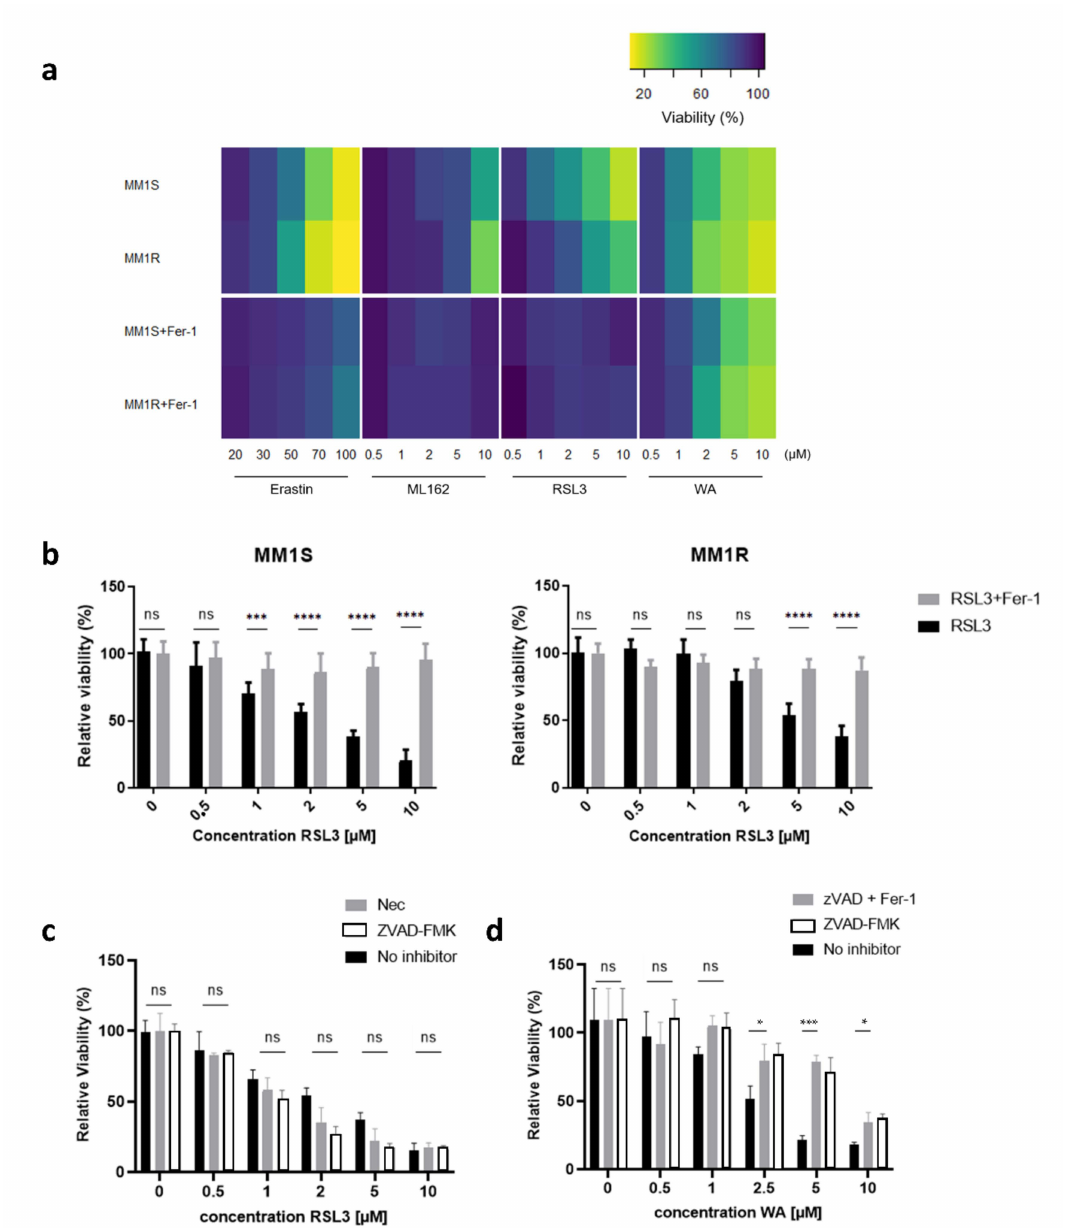
Figure 1. MM1 multiple myeloma cell lines are susceptible to ferroptosis induction. ( a ) Heatmap representing relative cell viability of MM1 cells upon 24 h exposure to increasing concentrations of erastin, ML162, RSL3, and withaferin A (WA) with or without pre-treatment with ferroptosis inhibitor ferrostatin-1 (Fer-1). ( b ) Relative cell viability of MM1S (left) and MM1R (right) cells upon 24 h exposure to increasing concentrations of RSL3 with or without pre-treatment with 2 µ M ferrostatin-1 (Fer-1). Data are plotted as the mean ± s.d., n = 3 biologically independent replicates (ns = p > 0.05, *** p < 0.001 **** p < 0.0001, ANOVA). ( c ) Relative viability of MM1 cells upon 24 h exposure to increasing concentrations of RSL3 with or without pre-treatment with 10 µ M necrostatin-1 (Nec) or 50 µ M caspase inhibitor ZVAD-FMK. Data are plotted as the mean ± s.d., n = 3 biologically independent replicates. ( d ) Relative viability of MM1 cells upon 24 h exposure to increasing concentrations of WA with or without pre-treatment with 10 µ M necrostatin-1 (Nec) or 50 µ M caspase inhibitor ZVAD-FMK (* p < 0.05). Data are plotted as the mean ± s.d., n = 3 biologically independent